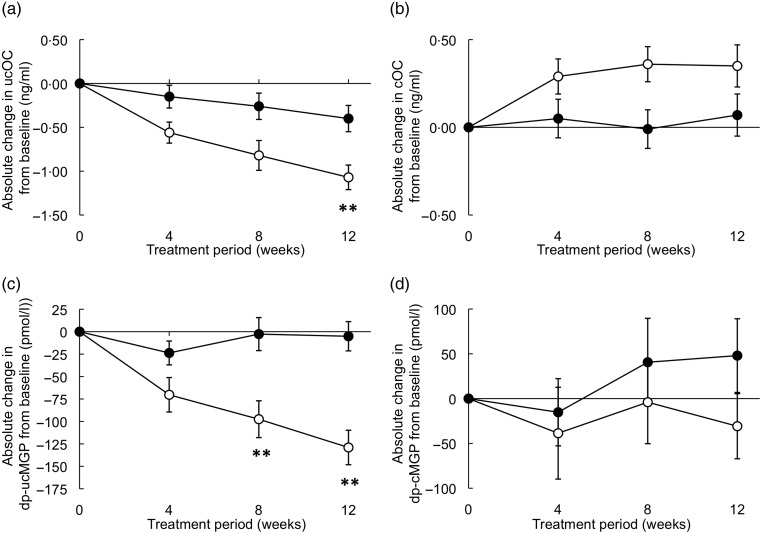
Effects of 12-week consumption of a fortified yogurt drink on markers of vitamin K status. Participants received twice per d either a basic yogurt drink (control group; ●) or a fortified yogurt drink (fortified with menaquinone-7, EPA + DHA, vitamin D, vitamin C, calcium and magnesium; ○) for 12 weeks. (a) Uncarboxylated osteocalcin (ucOC); (b) carboxylated osteocalcin (cOC); (c) desphospho-uncarboxylated matrix Gla-protein (dp-ucMGP); (d) desphospho-carboxylated matrix Gla-protein (dp-cMGP). Values are means (n 56), with standard errors represented by vertical bars. ** Mean value was significantly different from that for the control group (P < 0·017; correction for multiple comparisons, one-way ANOVA).